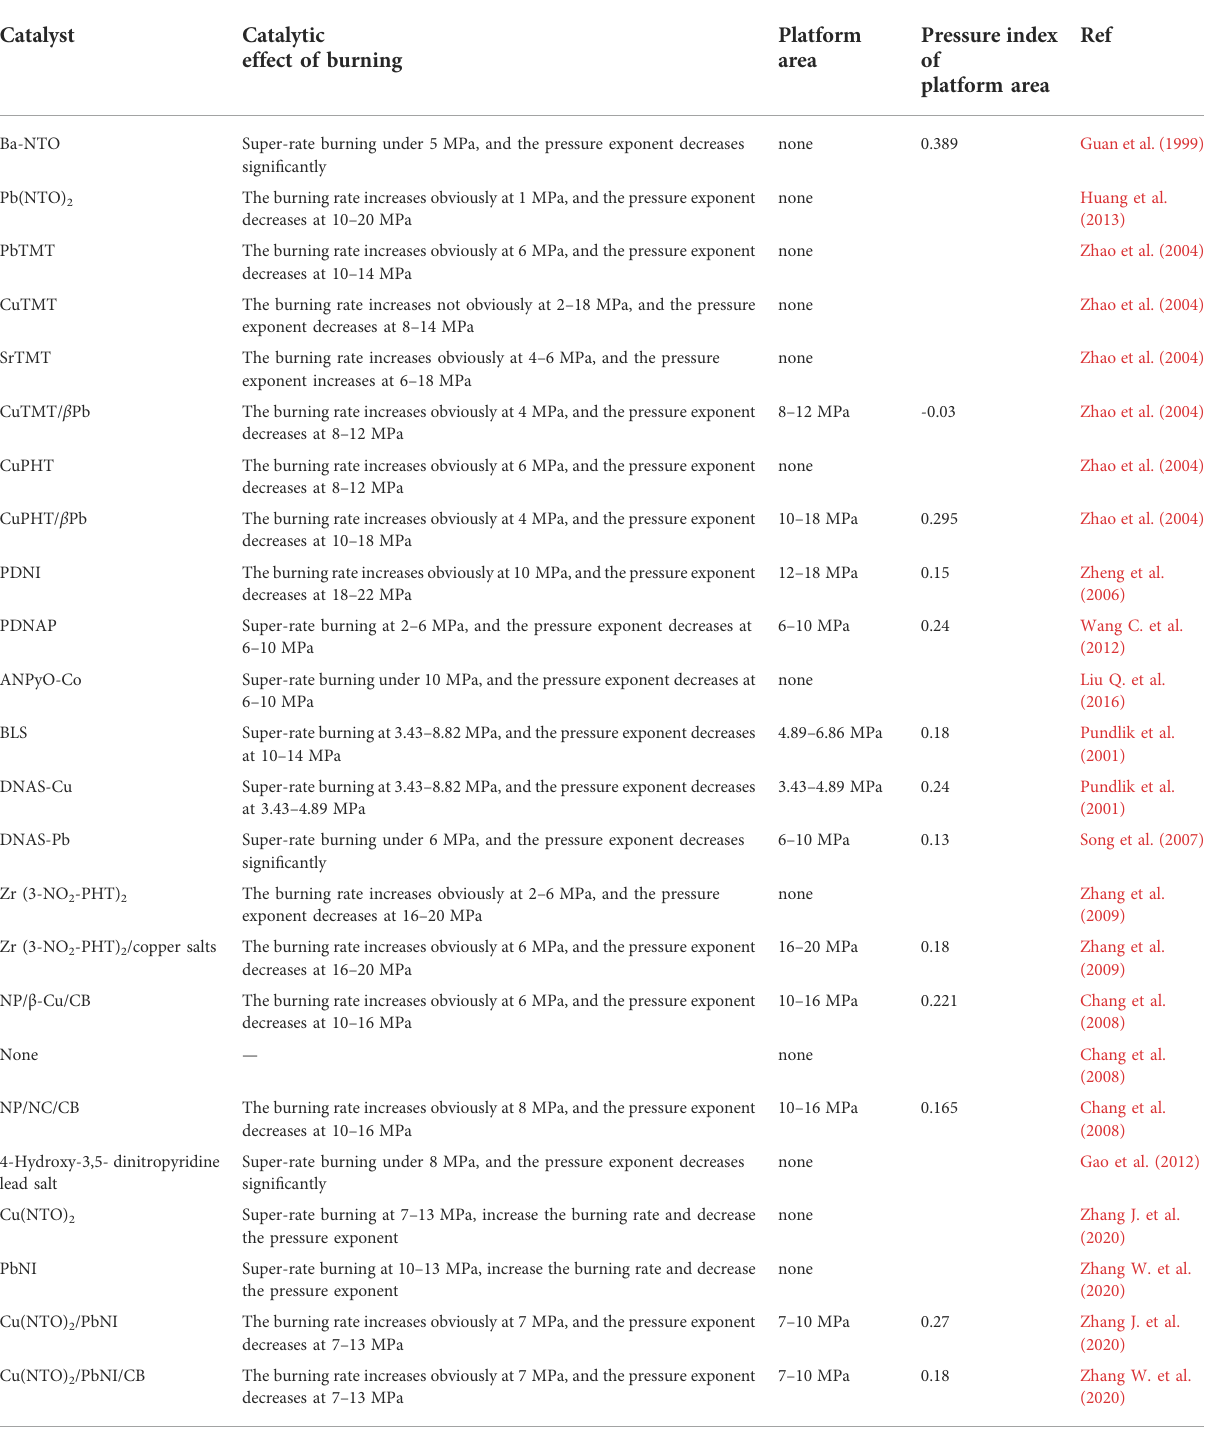
TABLE 4 Effect of different burning rate catalyst on burning performance of double base